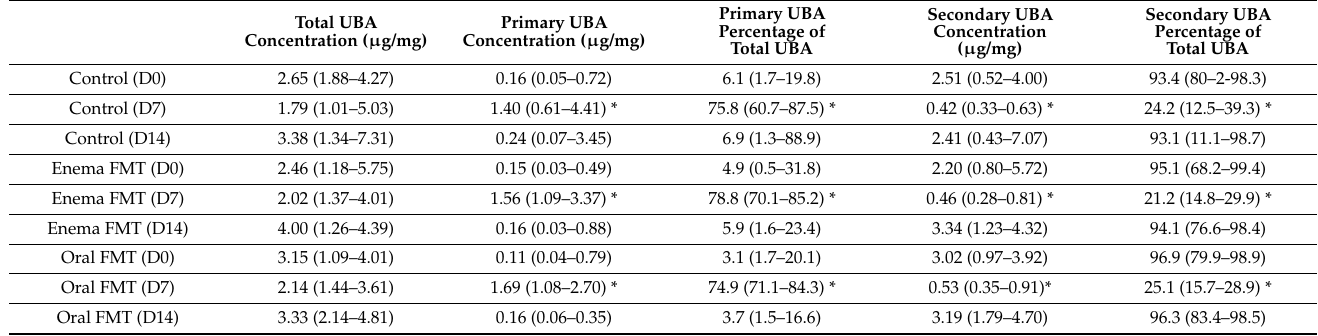
Table 2. Fecal concentrations of total UBA and total and relative fecal concentrations of pri- mary and secondary UBA at baseline (D0), end of tylosin treatment (D7) and 1 week after tylosin discontinuation